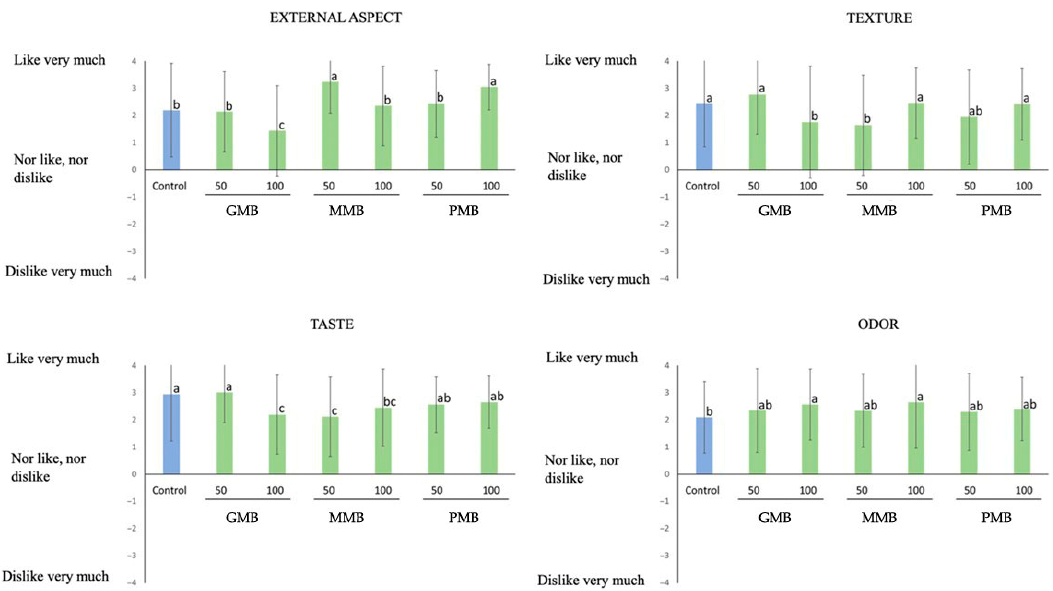
Figure 2. Results obtained in sensory evaluation of reformulated burgers with melon oil. Different letters in the columns show significant differences ( p < 0.05). Control: Deer meat (78.8%), pork fat (19%), corn-starch (1.4%), spices (0.8%); GMB 50: Pork fat (9.5%), gel emulsion (9.5%); GMB 100: Gel emulsion (19%); PMB 50: Pork fat (9.5%), particle emulsion (9.5%); PMB 100: Particle emulsion (19%); MMB 50: Pork fat (9.5%), maltodextrin emulsion (9.5%); MMB 100: Maltodextrin emulsion (19%). The rest of ingredients in the burgers are the same as the control.